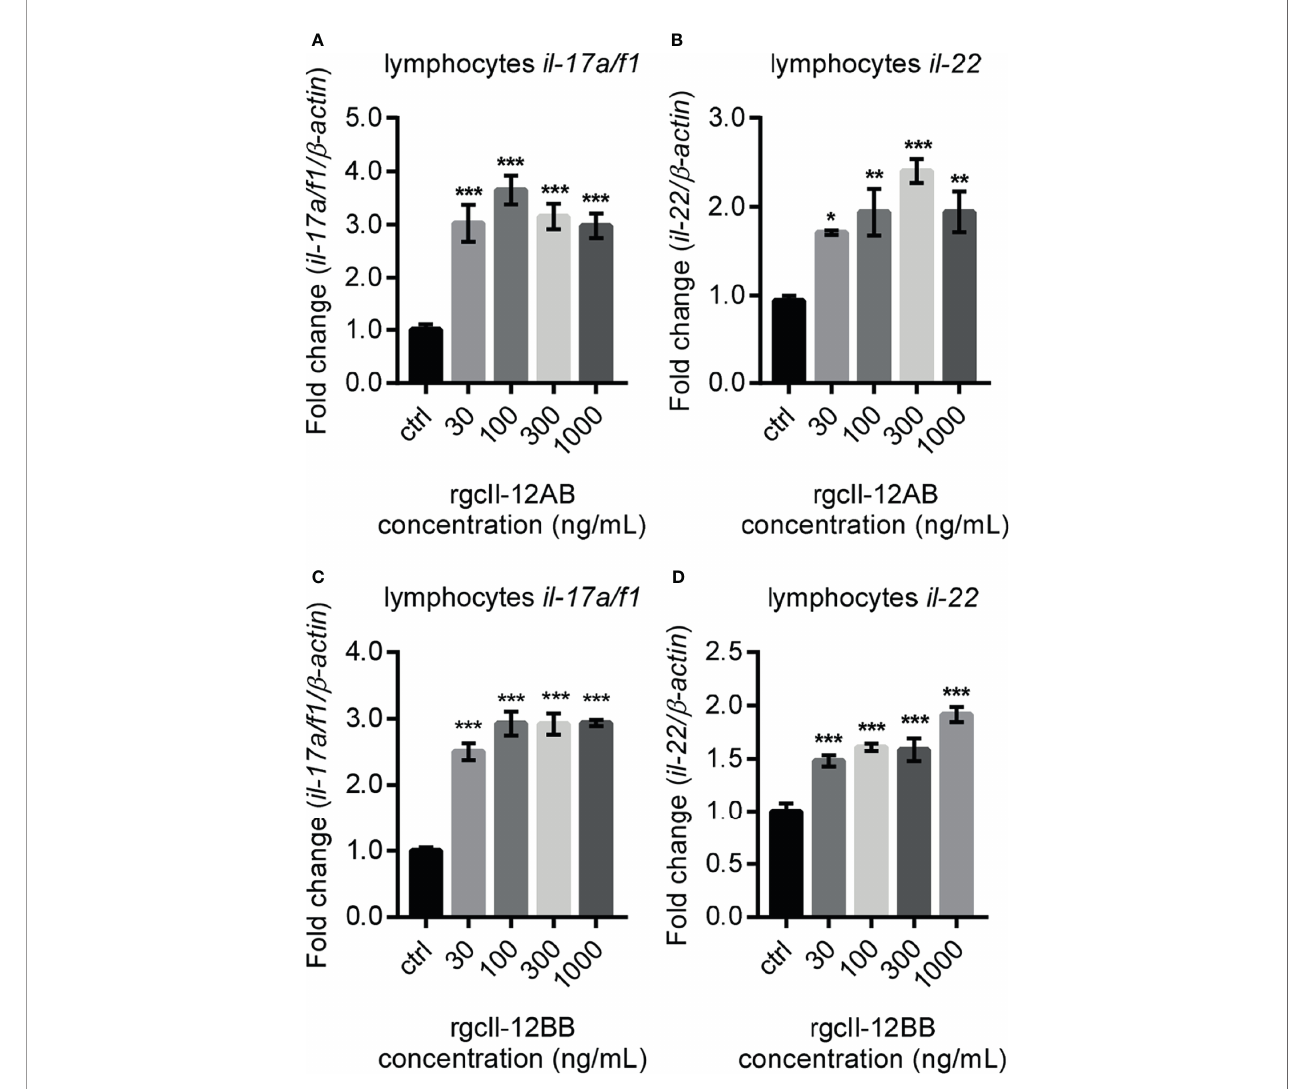
FIGURE 7 | Effects of rgcIl-12 isoforms on Th17-related cytokines mRNA expression in grass carp lymphocytes. Lymphocytes were treated with 30-1000 ng/mL rgcIl-12AB (A, B) or rgcIl-12BB (C, D) for 12 h. The mRNA expression of il-17a/f1 and il-22 mRNA were detected by qPCR and normalized by b -actin and expressed as fold changes compared with the control group. Data are shown as mean ± SEM (N = 4). * p < 0.05, ** p < 0.01, and *** p <